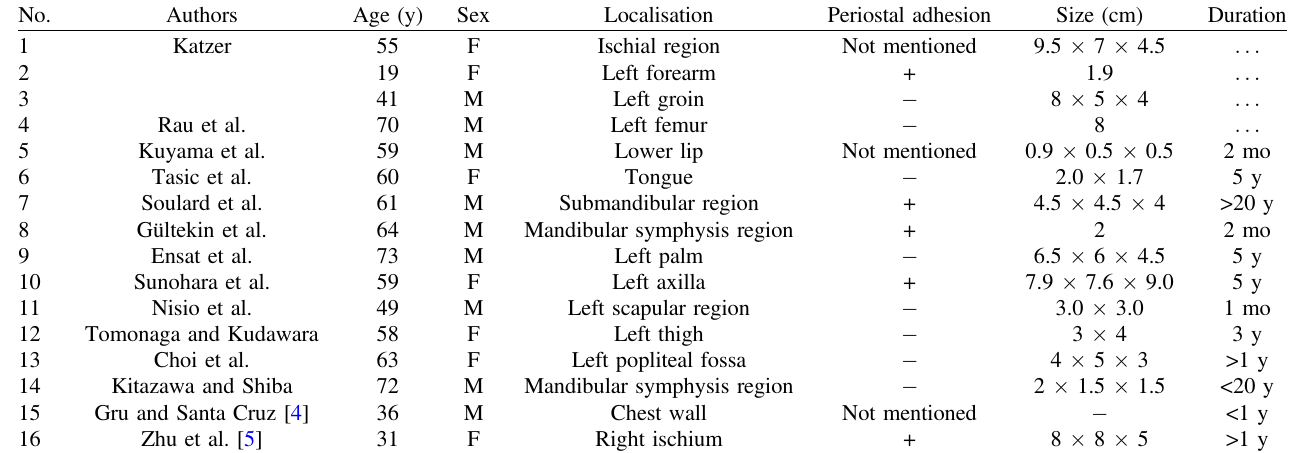
Table 1. Previously reported cases of osteochondrolipomas*.